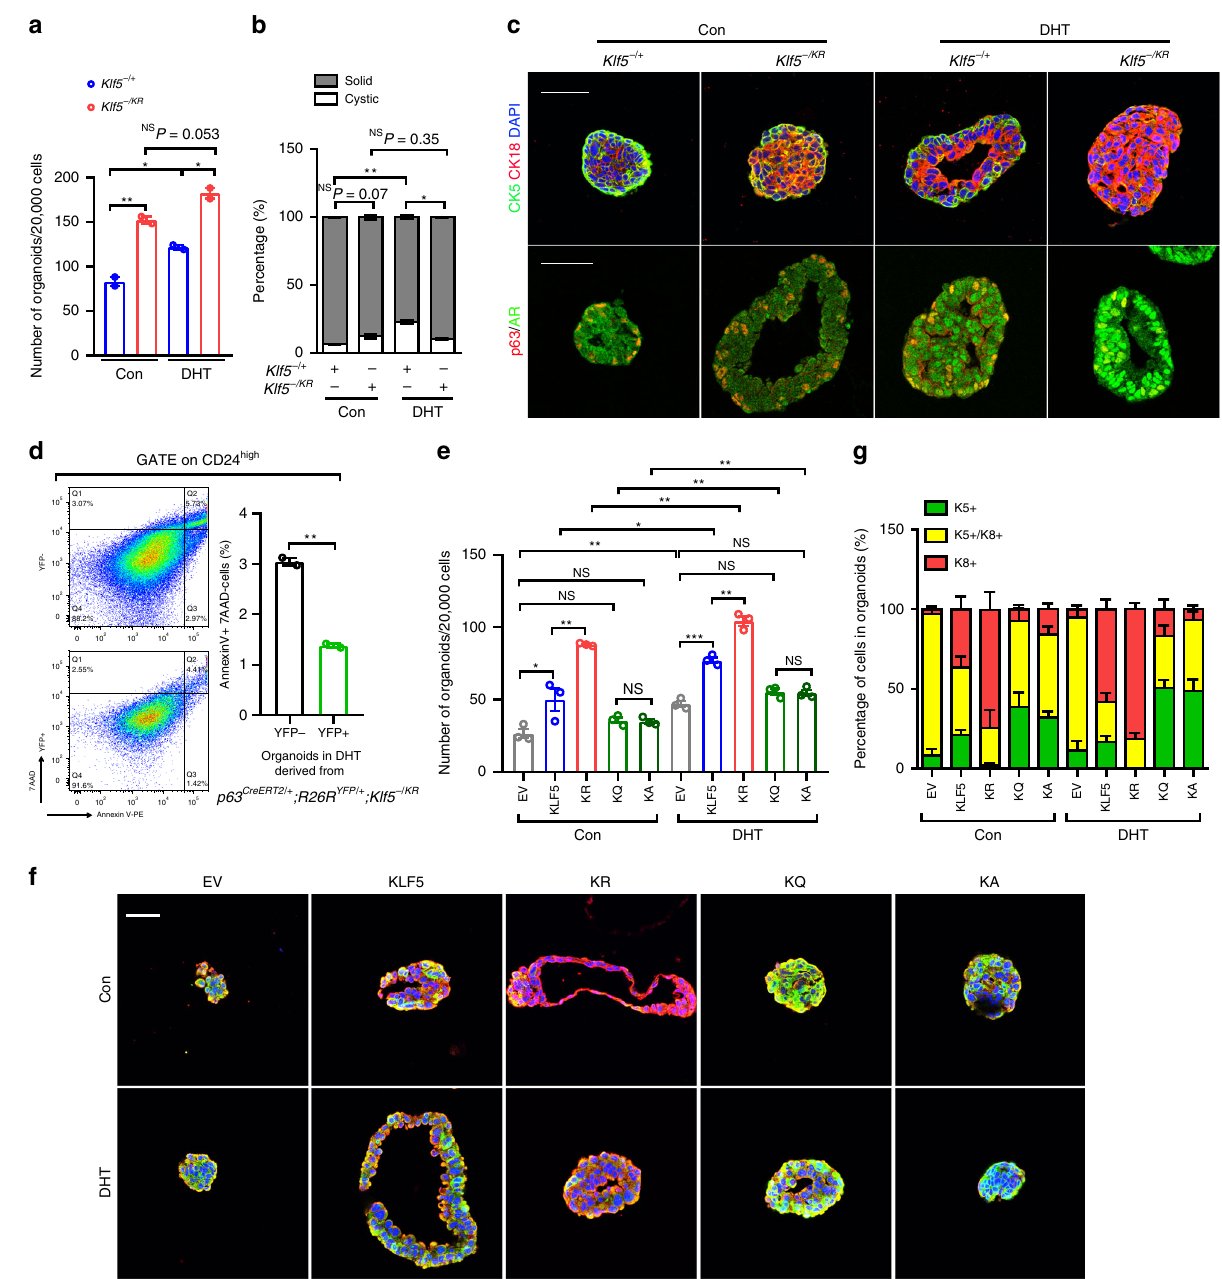
Fig. 5 Acetylation of Klf5 maintains proper basal to luminal differentiation. Cells used for organoid formation were isolated from p63 CreERT2/ + ;R26R YFP/ + mice with indicated Klf5 genotypes immediately after 5 days of tamoxifen treatment at day 18 after birth. a Knockin of Klf5 KR increased YFP + organoids, regardless of DHT conditions. b Knockin of Klf5 KR eliminated the induction of cystic organoids by DHT (1 nM). In a , b , n = two biologically independent samples. c Knockin of Klf5 KR gave rise to organoids with more luminal cells, as indicated by IF staining of basal markers p63 or CK5 and luminal markers CK18 or AR. d Klf5 KR mutant decreased apoptotic cells in organoids under DHT treatment, as indicated by fl ow cytometry. n = 2 biologically independent samples. The Klf5 KR mutant was knocked in to YFP + cells. e – g Wild-type KLF5 , KLF5 KR ( KR ), KLF5 KQ ( KQ ) and KLF5 KA ( KA ) mutants were ectopically expressed in prostate cells isolated from p63 CreERT2/ + ;R26R YFP/ + ; Klf5 − / − mice. EV, empty vector. e The number of organoids on day 6. DHT, 1 nM. n = 3 biologically independent samples. f Detection of basal marker CK5 and luminal marker CK8 in organoids by IF staining. g Statistical analysis of the composition of basal and luminal cells in organoids with different forms of KLF5 in f . n = 5 – 8 organoids. Representative images are selected based on the statistical analysis. Scale bar, 50 μ m. Data are shown in mean ± S.E.M. NS not signi fi cant; * P < 0.05; ** P < 0.01; *** P < 0.001 (two-tailed Student ’ s t -test). Source data are provided as a Source Data fi